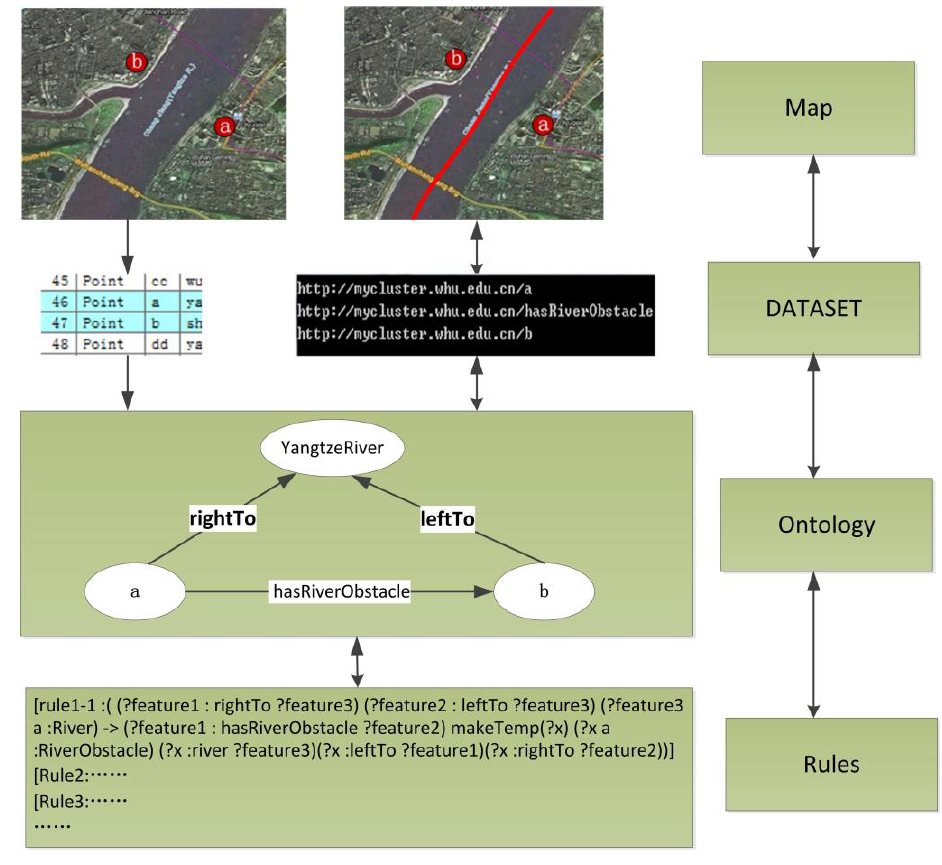
Figure 11. Reasoning process based on Rule.